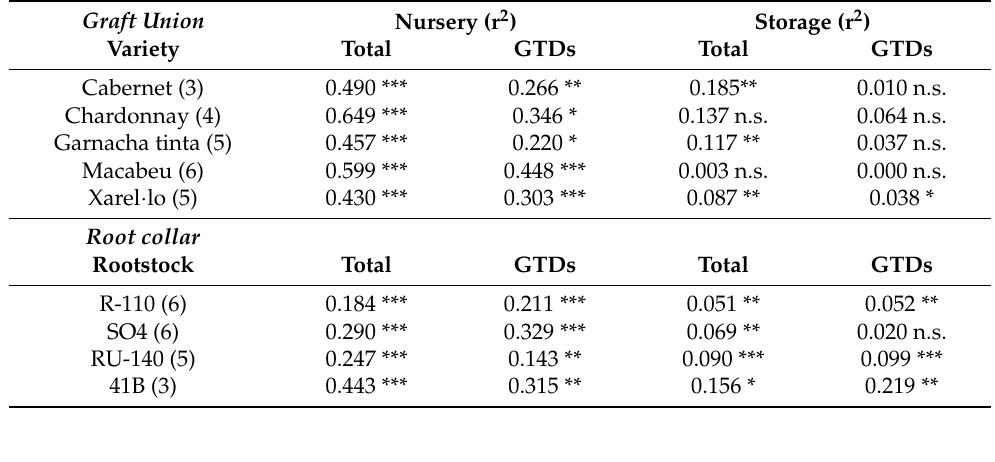
Table 4. Contribution of nursery and storage to the composition of fungal communities including all OTUs (total) and of only OTUs related to GTDs in different varieties and rootstocks. The number in parentheses indicates the number of nurseries the variety or rootstock was present in. Only varieties that were present in at least three nurseries are shown. Annotation next to the numbers indicates